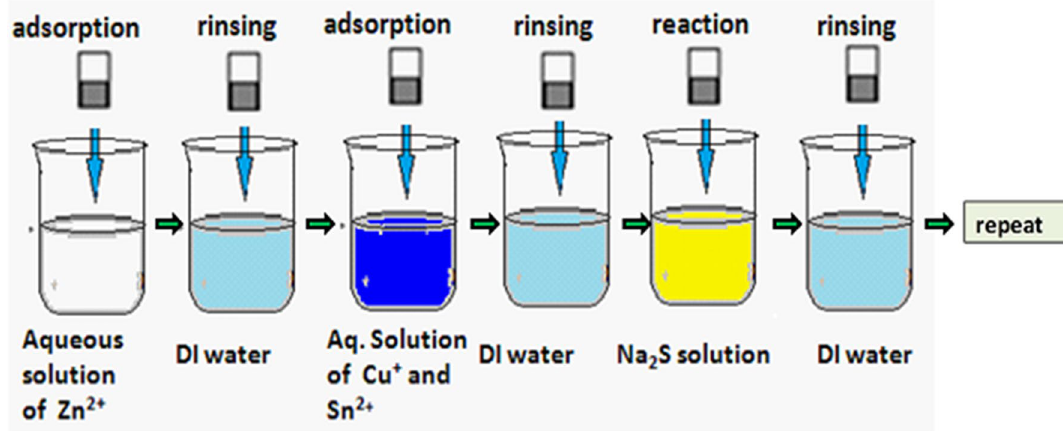
Fig. 1 Six dip SILAR cycle giving augmented Zn